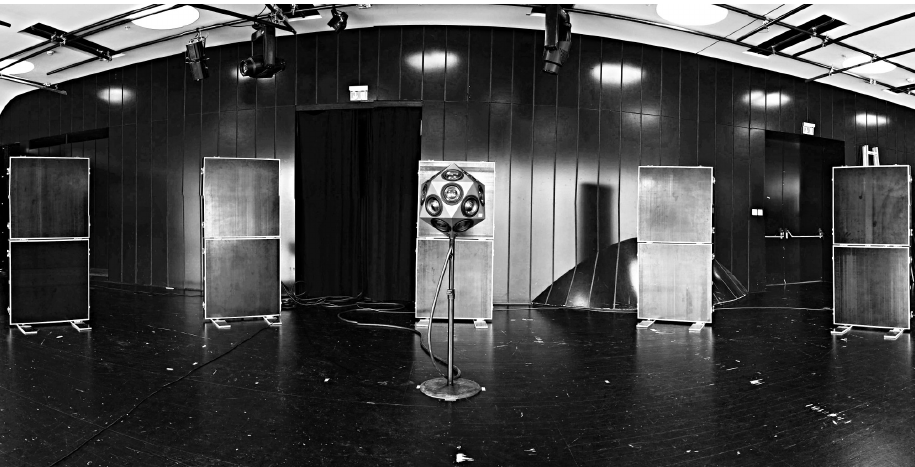
Figure 1. The IKO in a typical concert situation with reflector panels (Studiobühne MUMUTH,